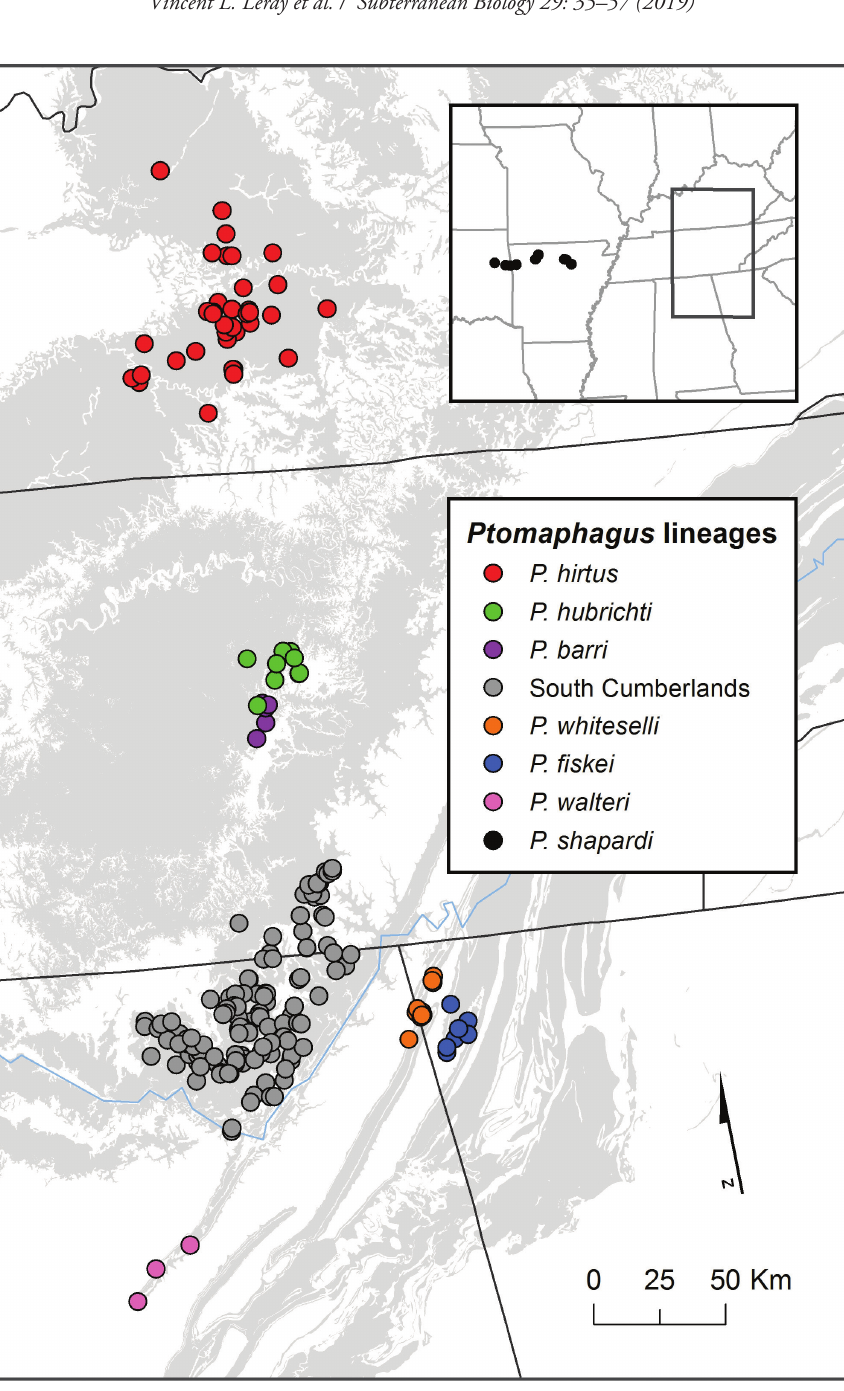
Figure 2A. Distribution of hirtus -group species. All known sites for hirtus -group species in Kentucky, Tennessee, Alabama, and Georgia. P. shapardi sites in Oklahoma and Arkansas are indicated in upper right inset map. A dozen species from the southern Cumberland Plateau in Tennessee and Alabama are combined